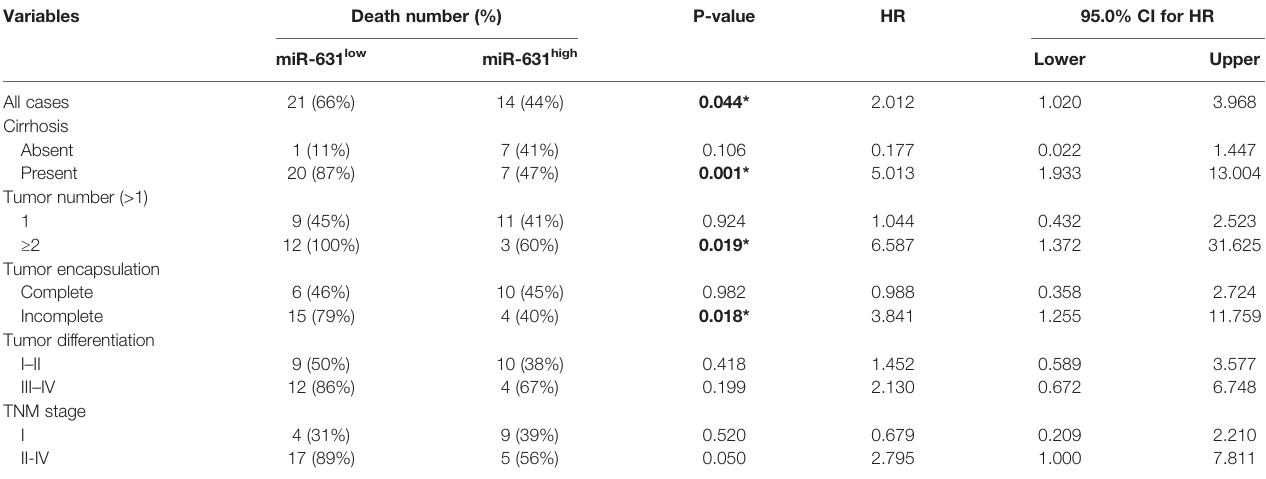
TABLE 2 | Univariate strati fi ed cox analysis of prognostic factors.